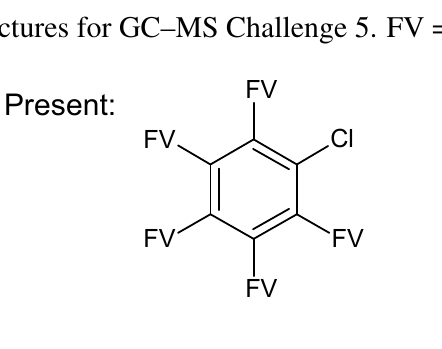
Figure A5. Substructures for GC–MS Challenge 6. FV = free valence.